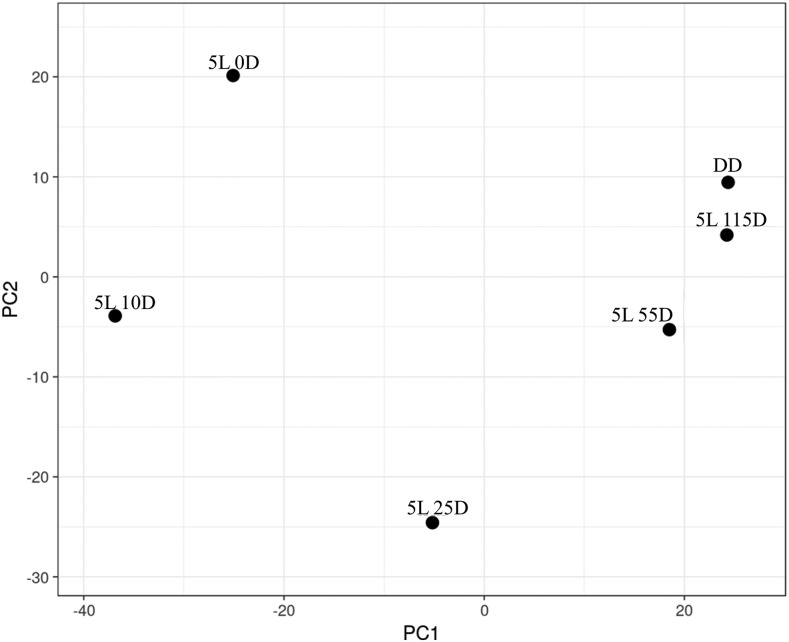
Principal component analysis for the 1128 light-regulated genes. Changes at mRNA level occurred mostly in the first 30 min after light exposure and not at later time points.